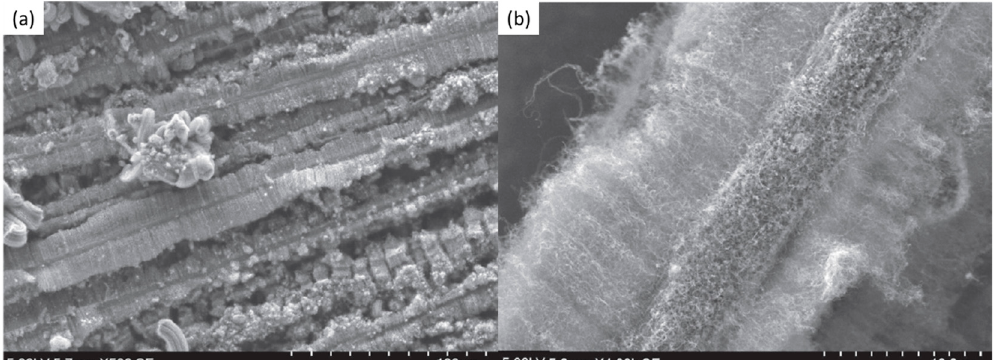
Figure 26. ( a ) CVD-grown VACNT across thin-ply CF tape; ( b ) idem at higher magnification. Reproduced with permission from Russello, Composite Structures; Ref. [125] copyright 2018, Elsevier.